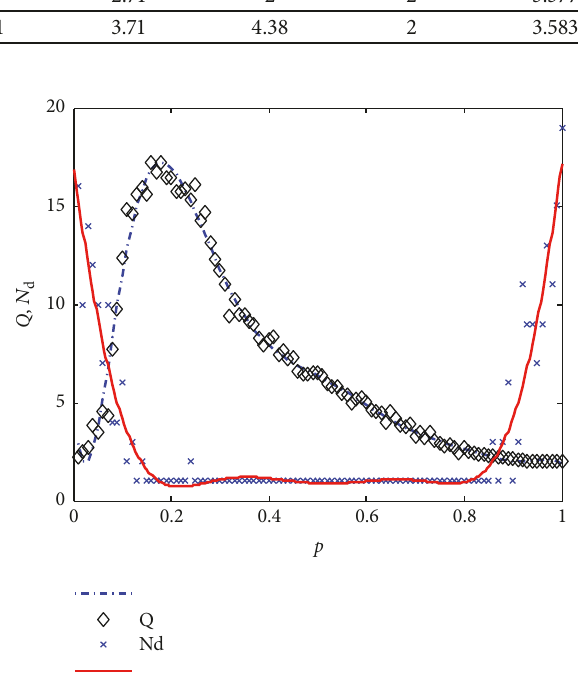
Figure 2: Trend of controllability and drive nodes of ER network with connectivity probability 𝑝 varying across [0,1]